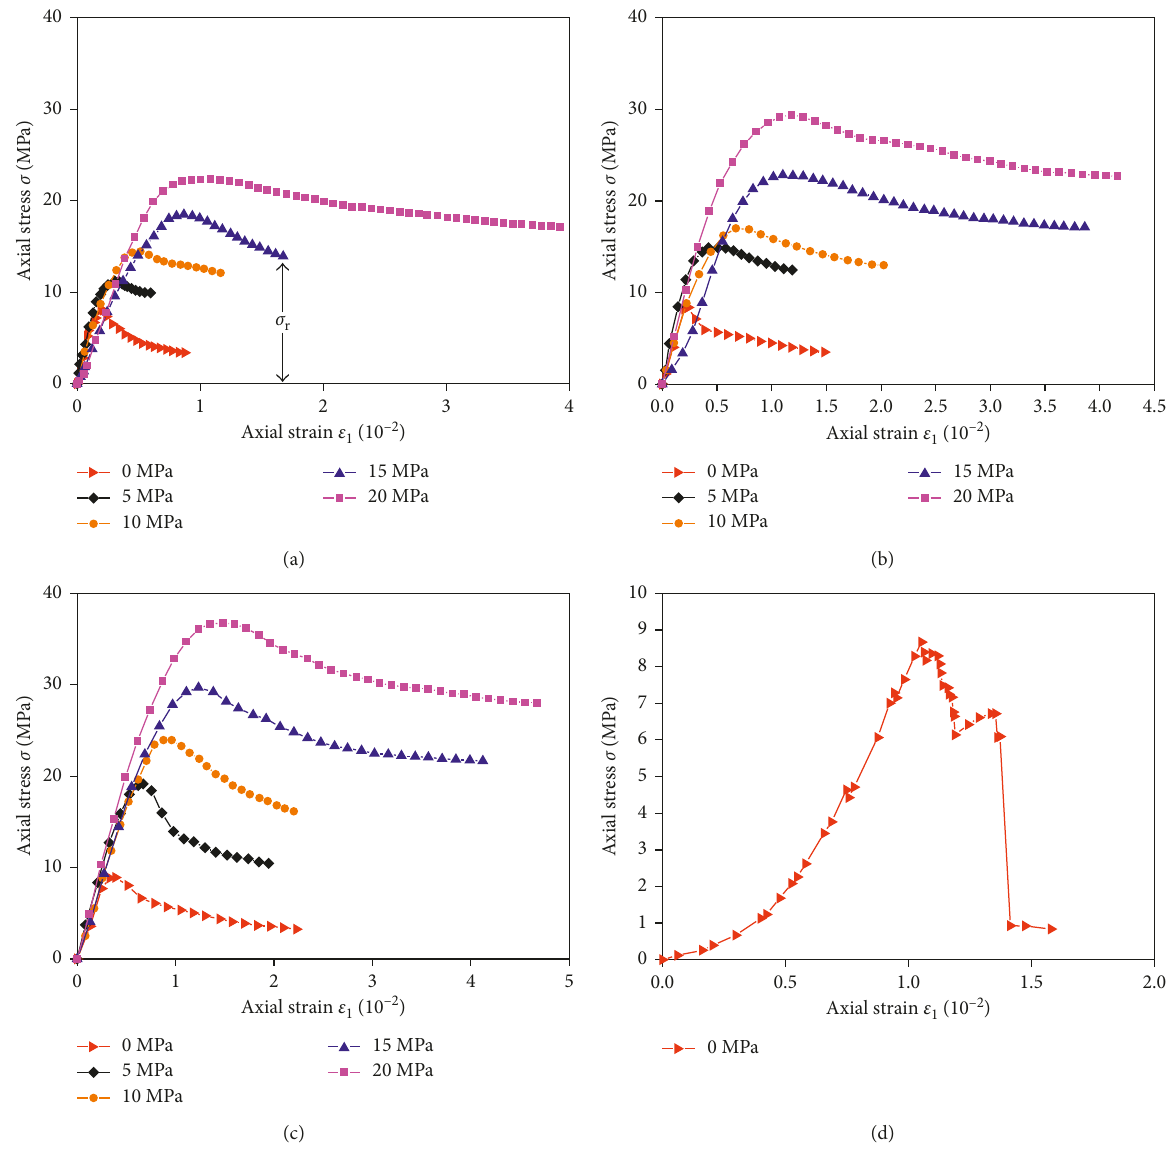
Figure 7: Stress-strain curves of grouted crushed coal specimens with different grain size mixtures under different confining pressures. (a) Small specimen, (b) medium specimen, (c) large specimen, and (d) representative original coal